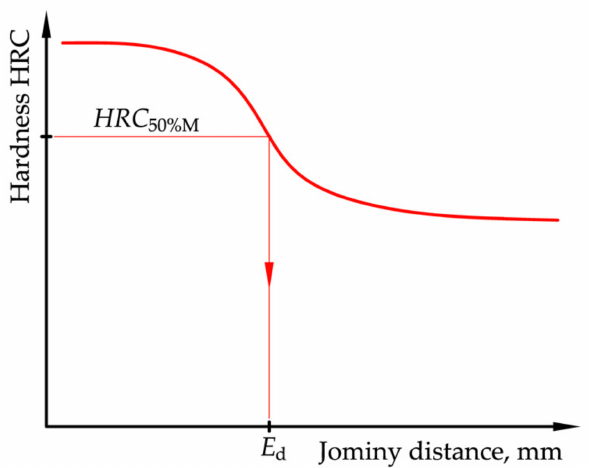
Figure 1. Specific Jominy